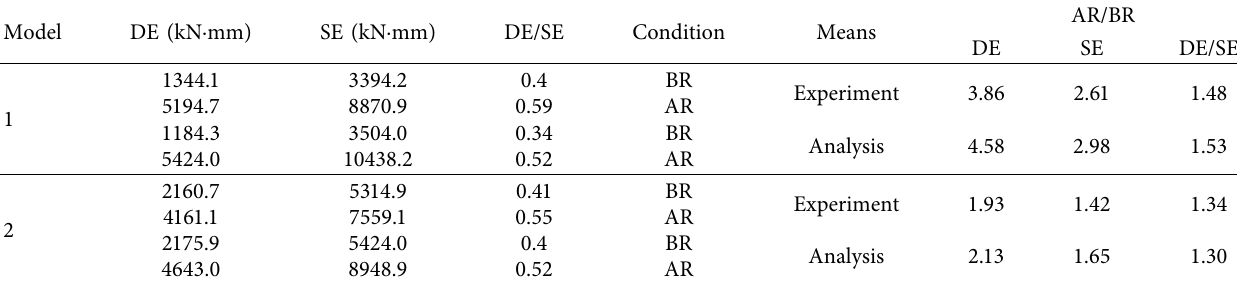
Table 5: The energy dissipation capacity of joints.